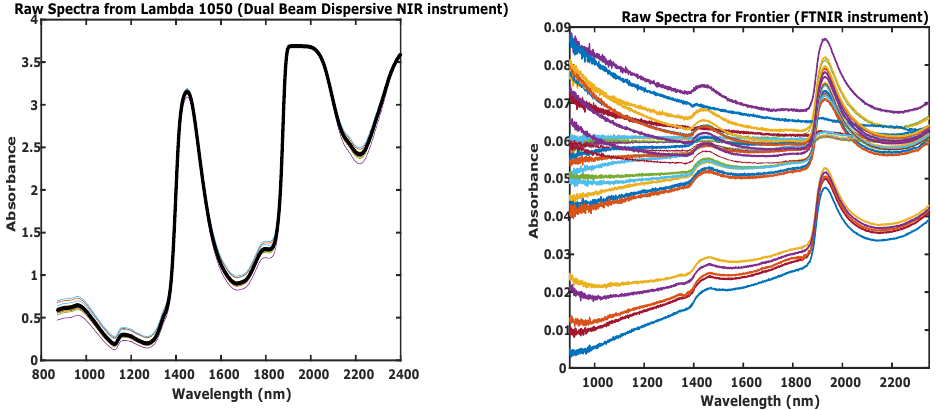
Figure 1. Raw Spectra of the 41 samples (different concentrations) of lactate for ( left ) Lambda 1050 (dual beam dispersive NIR instrument) and ( right ) Frontier (FTNIR instrument). The different coloured spectra depict the concentrations of lactate from 4.5 to 13.8 mM at 0.5 mM intervals. Table 2. Linear Regression on observed peaks (nm) arising in the spectra due to O-H bonds. (coeffi- cient and Standard errors in parenthesis. p -values depict statistical significance markers ≤ 0.05). Wavelength